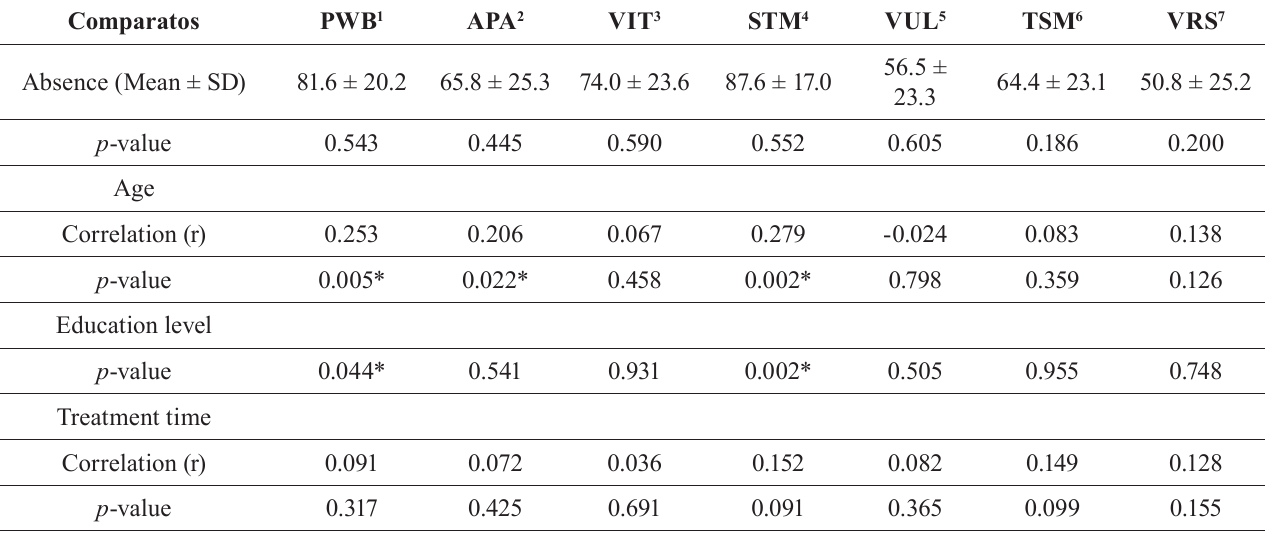
TABLE V - R esults of the analysis of the quality of life domains of the 124 patients with HBC and the co-variables gender, marital status, comorbidities, age and time of treatment